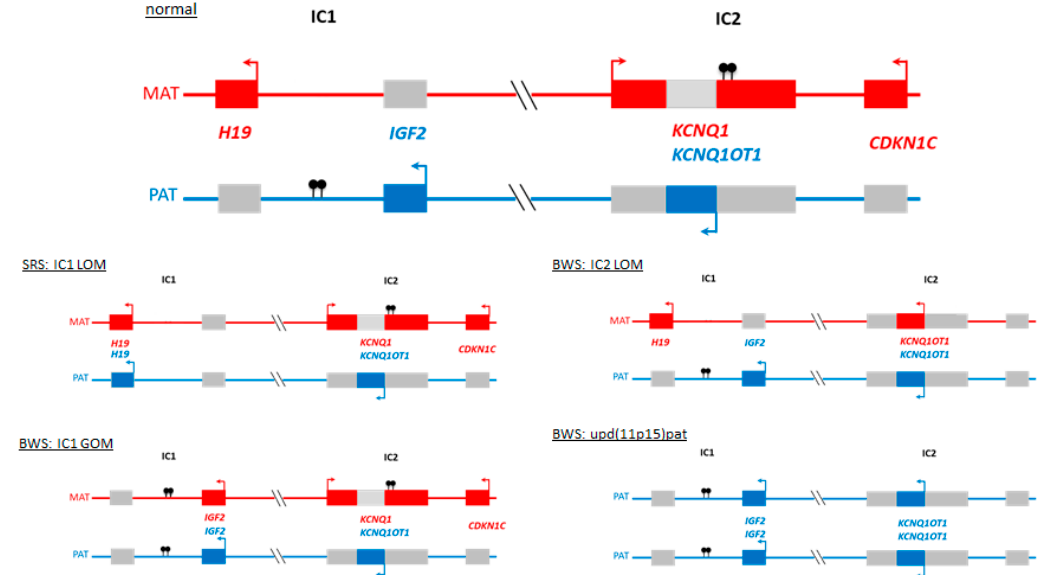
Figure 2. The imprinted 11p15.5 regions IC1 and IC2: normal situation and the major molecular alterations detectable in patients with SRS and BWS. (MAT maternal chromosome, red genes expressed from the maternal allele only; PAT paternal chromosome, blue genes expressed from the paternal allele only; grey silent gene copies; arrows indicate expressed allele; filled lollipops indicate methylation).